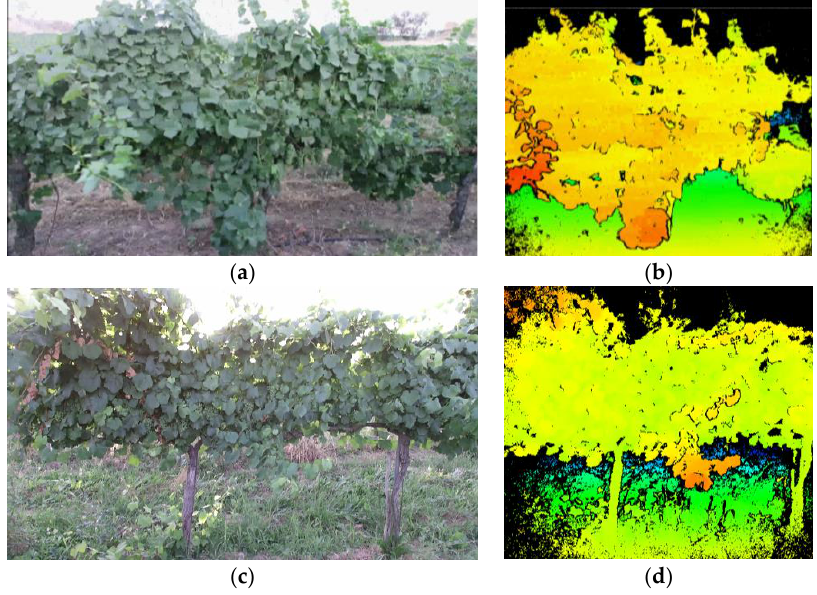
Figure 11. ( a , c ) RGB images supplied by the Kinect v2 sensor; and ( b , d ) examples of the depth images supplied by the Kinect v2 sensor simultaneous to when images ( a , c ) were obtained.